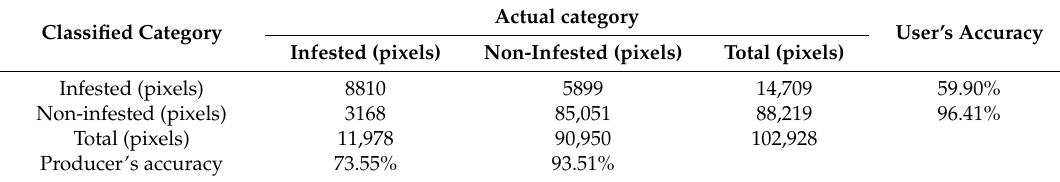
Table 4. Error matrix for classification map generated by the whole study area Sentinel-2A